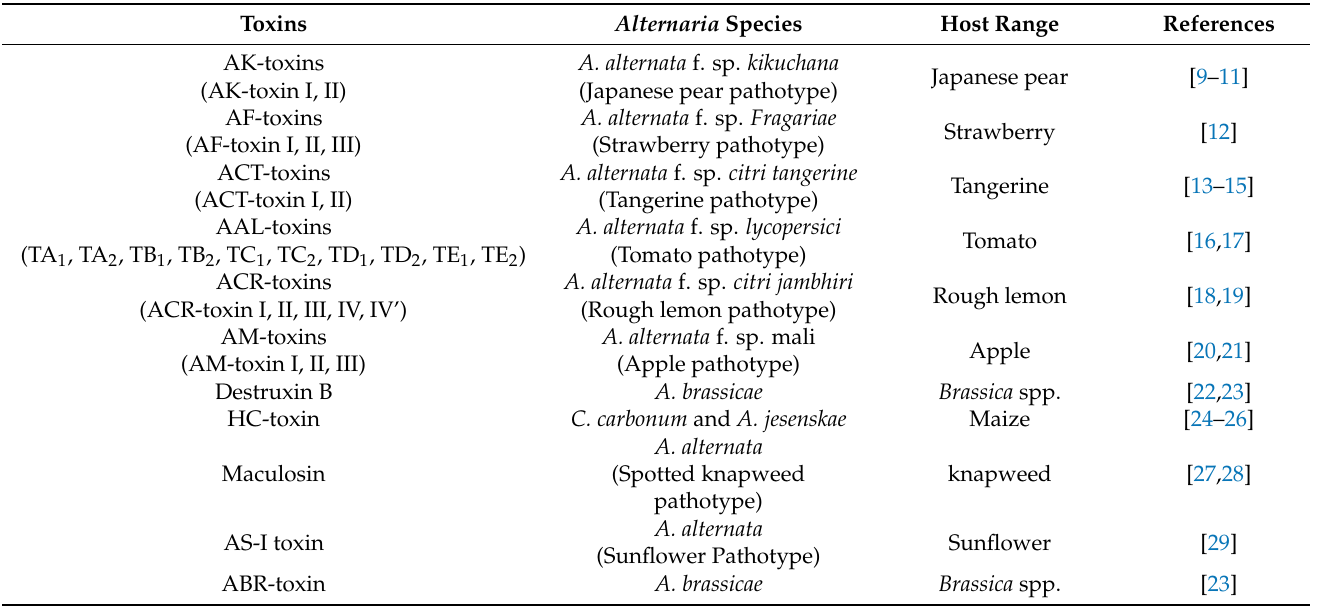
Table 1. Host-selective toxins produced by Alternaria